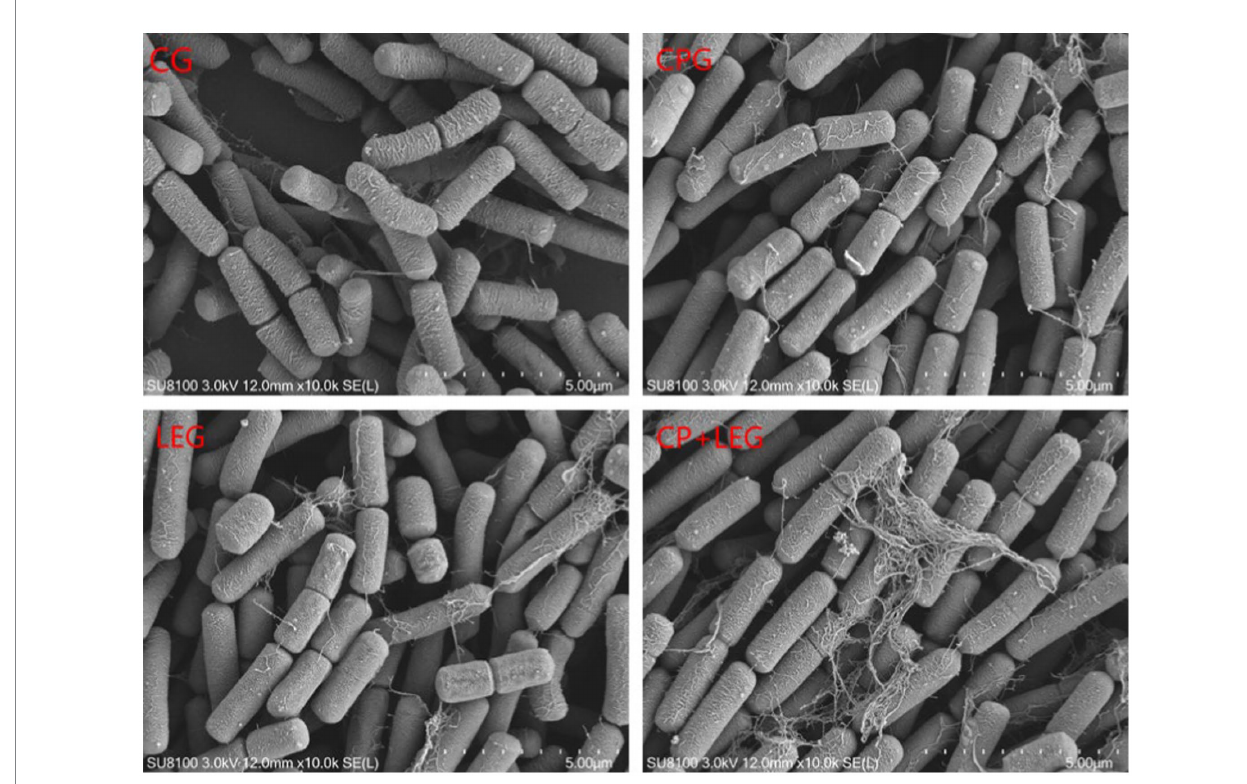
FIGURE 5 Effects of preservation methods on the morphology of Bacillus subtilis. CG, the control group; CPG, the compound preservative group; LEG, the low voltage variable frequency electric field group; CP+LEG, the compound preservative combined with low voltage variable frequency electric field